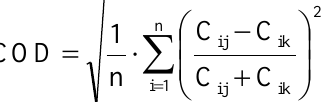
Figure 1. The locations of the PM